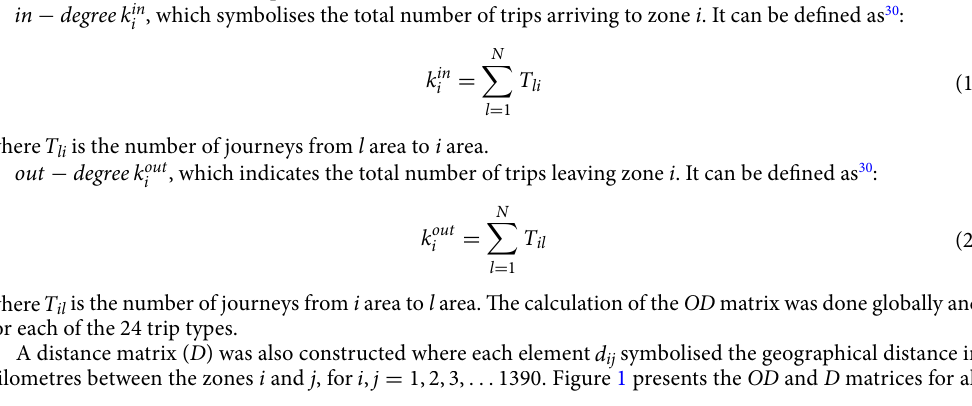
Type of primary transport used for the trip Number Percentage (%)